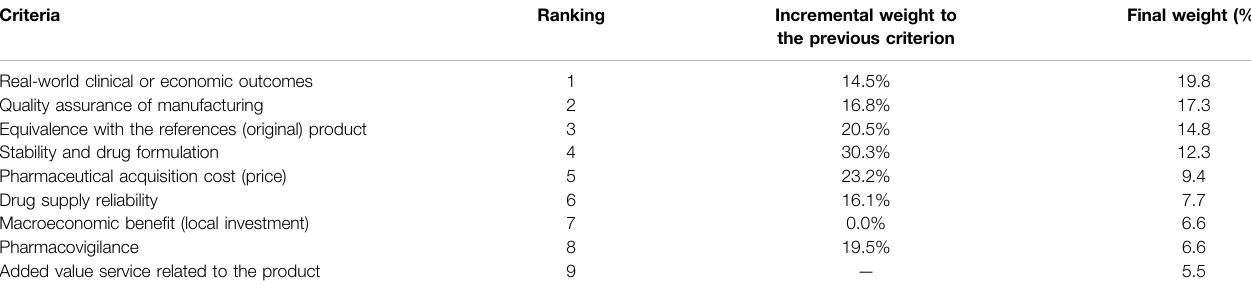
TABLE 1 | Ranking and weight of criteria in the pilot MCDA tool to facilitate policy decisions of off-patent pharmaceuticals in Dubai. Criteria